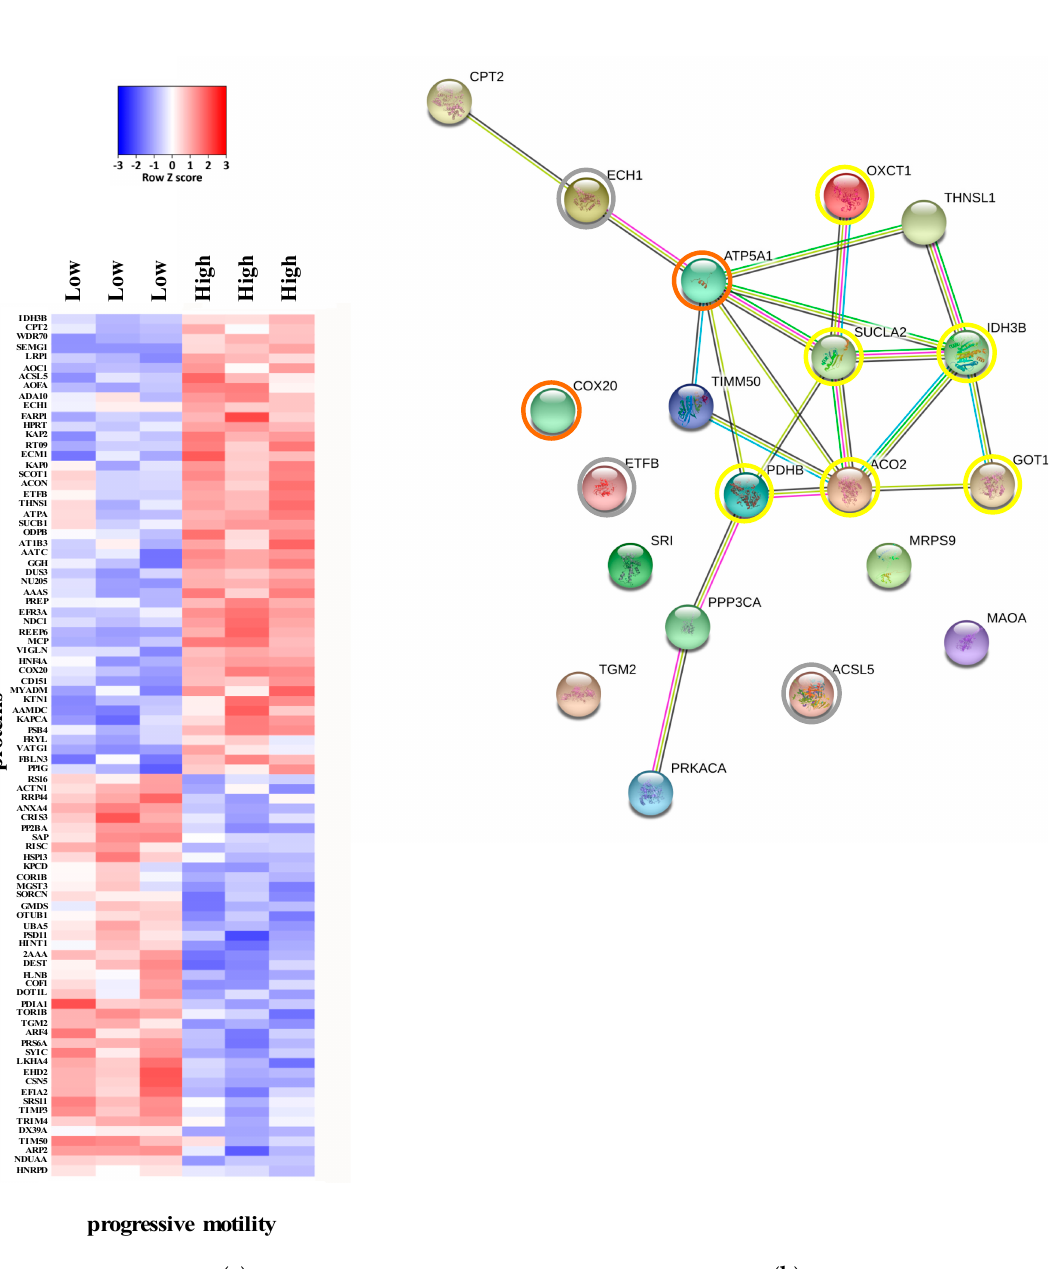
Figure 3. ( a ) Heat map of the expression of proteins which showed p < 0.05 in an unpaired, two tails t-test low group (asthenozoospermic samples with ~12% of progressive motility) vs. high group (normozoosperic samples with ~44% of progressive motility). ( b ) Interactions among the four proteins involved in the fatty acids catabolism process (grey circles), TCA process (yellow circles) and OXPHOS process (orange circles) down-regulated in the human samples with low progressive motility in comparison to normozoosperic samples. Interactions maps were prepared using the STRING database. Thicker lines represent stronger associations, and thinner lines represent medium associations.